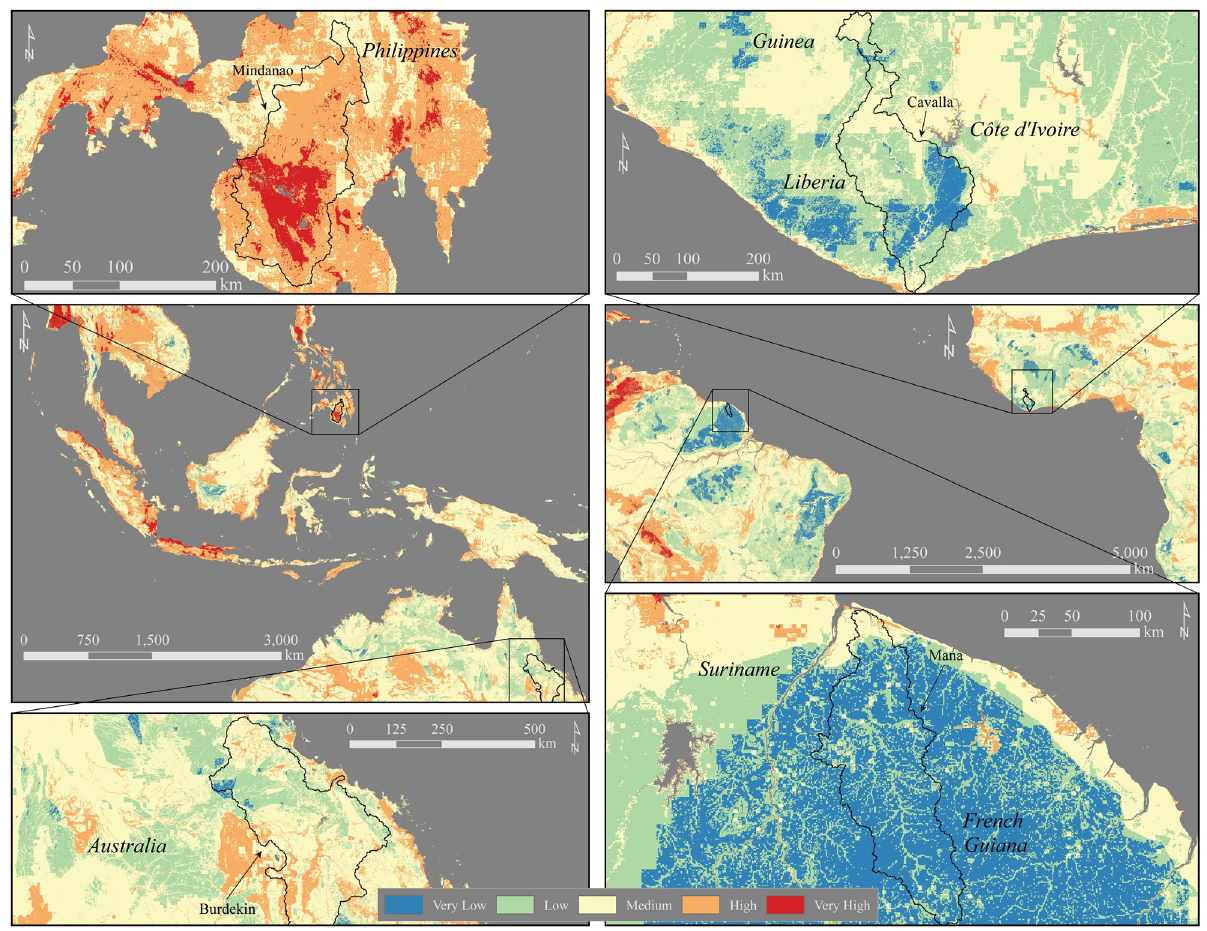
Figure 2. Erosion Vulnerability Index (EVI) in four case study locations. Top Left: The Mindanao watershed, Mindanao, The Republic of the Philippines, dominated by High and Very High Risk Categories. Center Left: Southeast Asia and Oceania. Bottom Left: The Burdekin watershed, Queensland, Australia, note the difference in Risk Categories from the upper watershed toward the coast. Top Right: The Cavalla watershed, Liberia, Guinea, and Côte d’Ivoire, note the prevalence of Low and Very Low Risk Categories. Center Right: Eastern South America and western Africa. Bottom Right: The Mana watershed, French Guiana, covered almost completely by Very Low Risk Categories. This figure was created using ESRI ArcDesktop 10.6, www. esri.